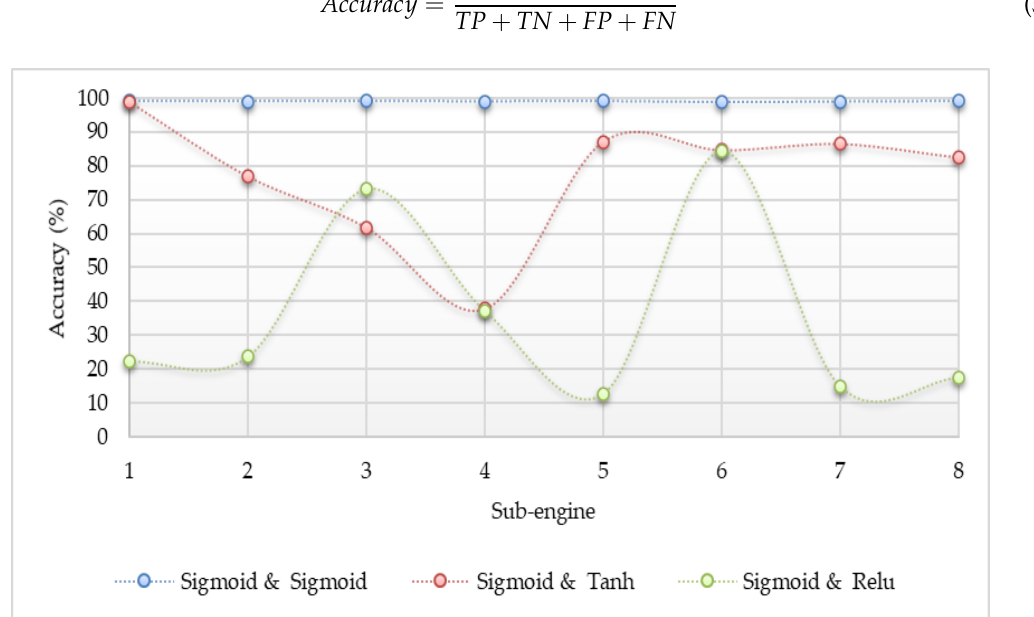
Figure 3. Accuracy comparison for detecting Internet of Things (IoT) botnet attacks by a simple neural network (sigmoid in the hidden layer and different functions in the output layer).